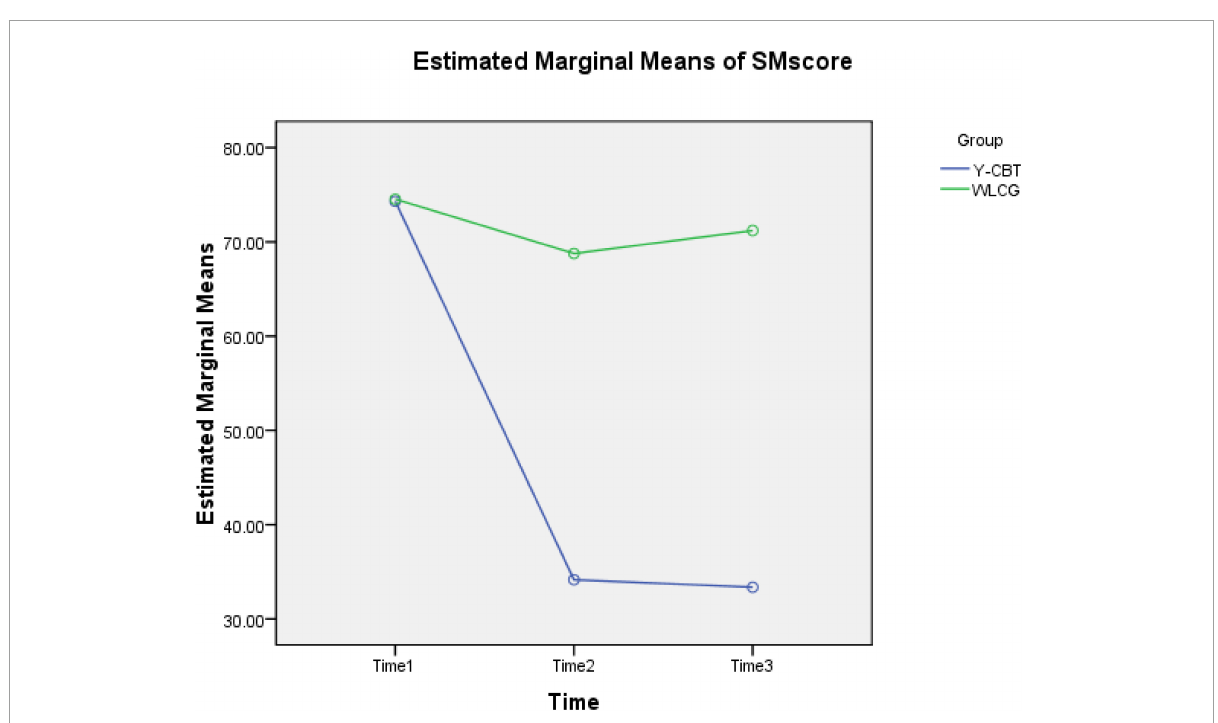
FIGURE4 Interaction effect of time and intervention on participants’ SM